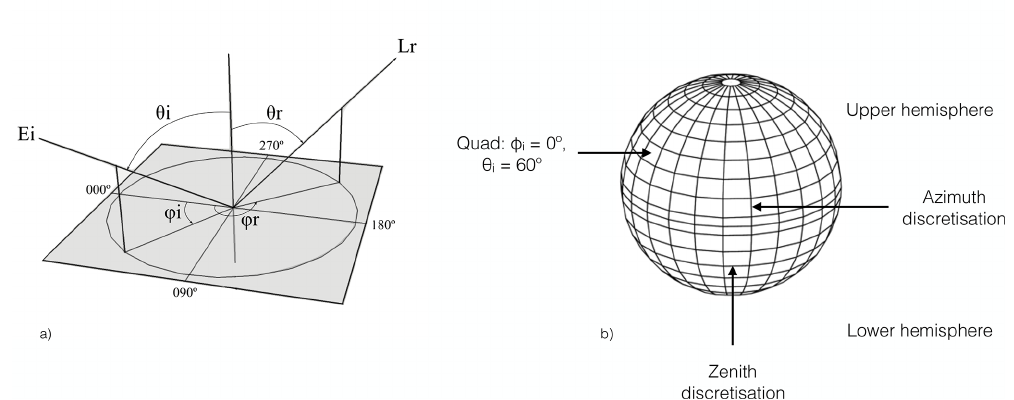
Figure 1. (a) Diagram of the incident and viewing configuration defining CCRF. E i is the irradiance from the azimuth angle φ i and the zenith angle θ i . L r is the radiance in the azimuth angle φ r and zenith angle θr . In this study, φ i was fixed to 180 ◦ , with the model being rotationally invariant. (b) Diagram of the directional surface discretisation scheme used by PlanarRad to compute CCRF. Adapted from Hedley (2008).